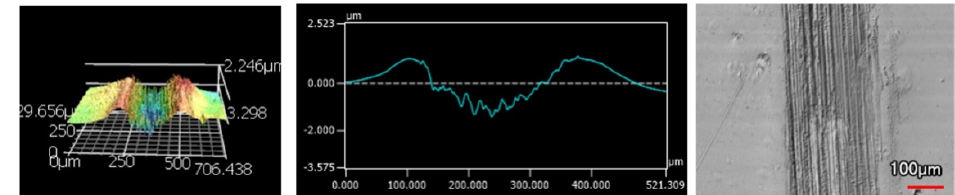
13 Figure 12. 45 μ m Thick Ni-P Coating 100 Passes of the Sharp Indenter. Figure 13. 9 μ m Thick Ni-P Coating 100 Passes of the Sharp Indenter. Figure 14. 9 μ m Thick Ni-P-NiTi Coating 100 Passes of the Sharp Indenter. Figure 15. 4 μ m Thick Ni-P-NiTi Coating 100 Passes of the Sharp Indenter.